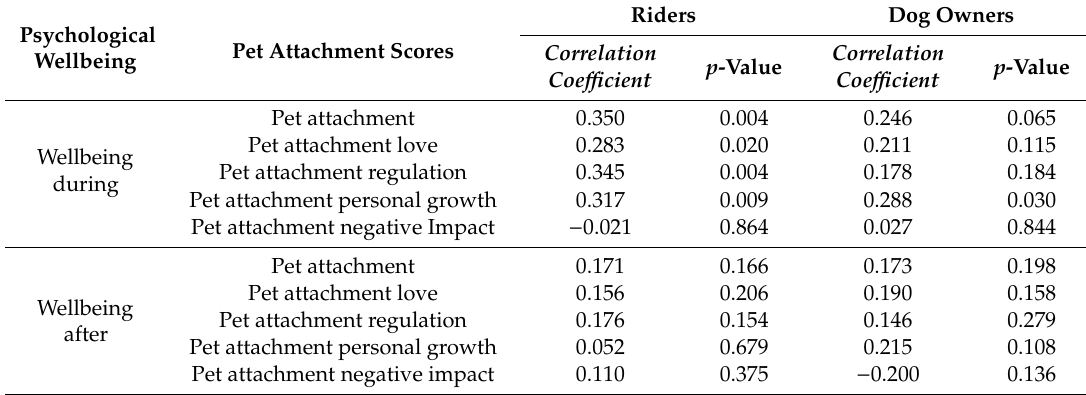
Table 4. Spearman correlation of psychological wellbeing and pet attachment scores.